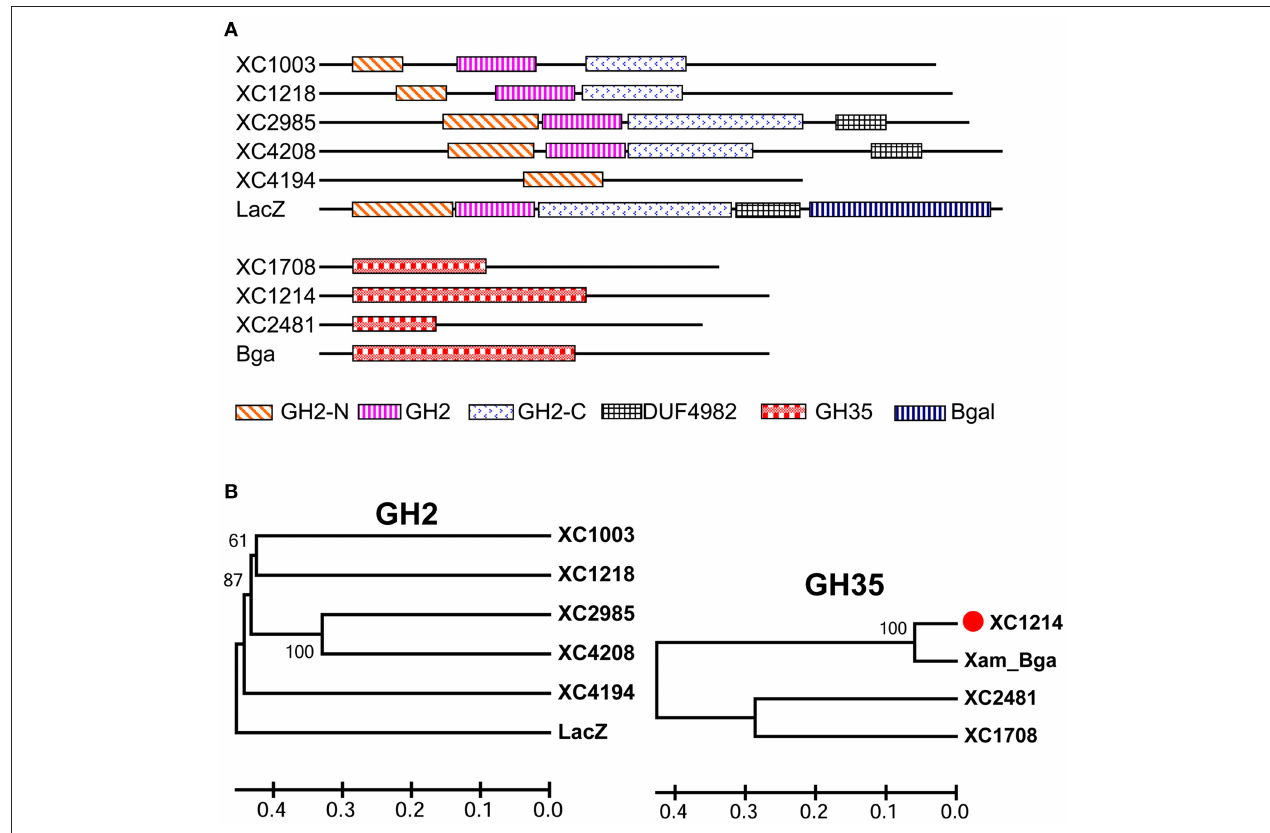
FIGURE 1 | The putative β -galactosidases in Xcc 8004. (A) The domains in the eight putative β -galactosidases of Xcc 8004, the LacZ of E. coli and Bga of X. axonopodis pv. manihotis predicted by CDD-BLAST. (B) The evolutionary relationship of the two protein (GH2 and GH35) families of Xcc putative β -galactosidases computed with the UPGMA rule in MEGA6 software and full-length proteins. The horizontal axis shows the Nei distance.